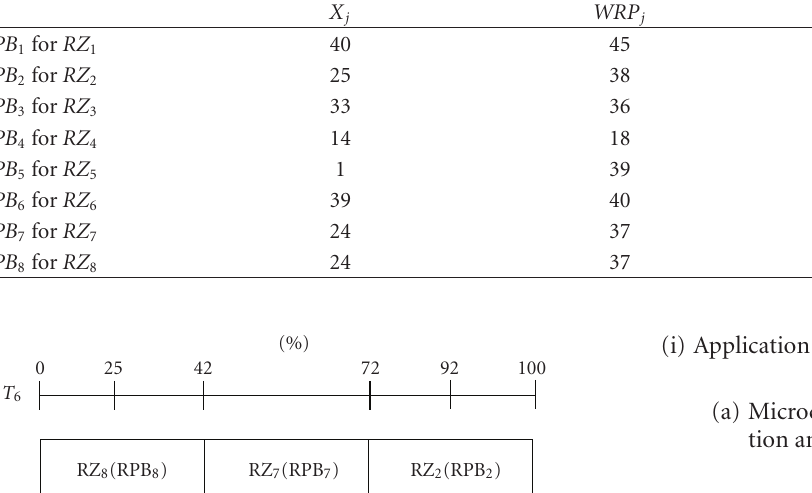
Figure 9: Mapping of preemption points of T 6